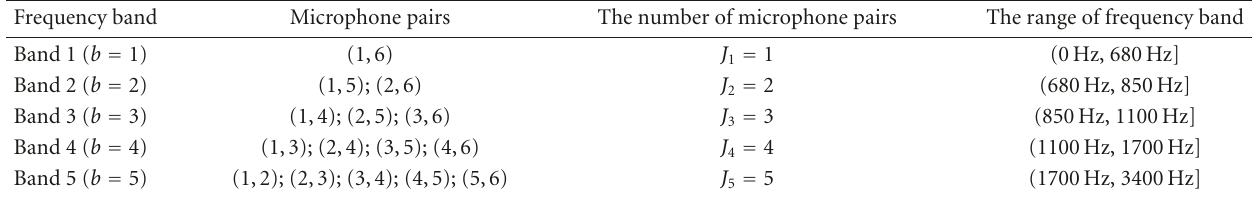
Table 3: The frequency bands correspond to the microphone